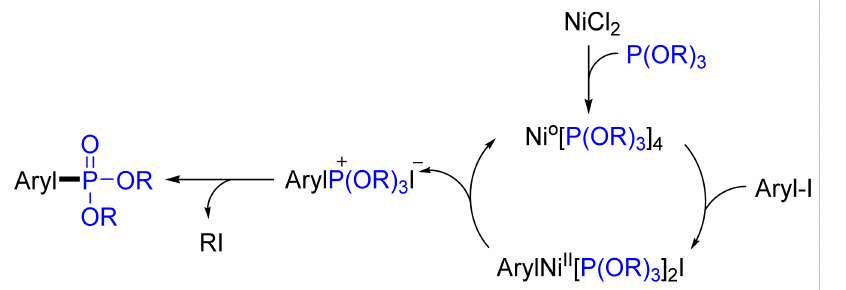
Figure 30. Proposed mechanism for the Ni-catalyzed cross-coupling of trialkyl phosphites with aryl iodides.